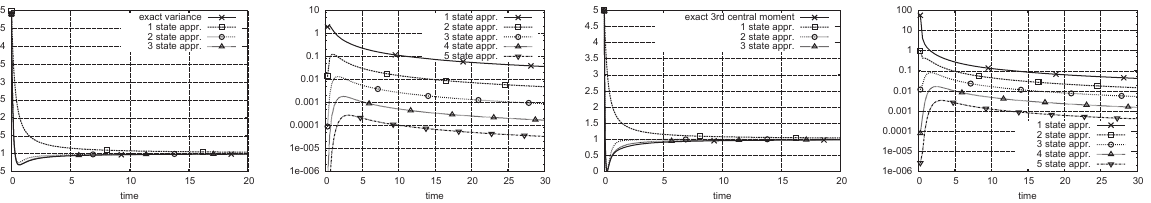
Figure 2: Variance (first plot), relative error of variance (second), third central moment (third) and relative error of the third central moment (fourth) with λ = 1 ,μ = 5 and initially empty system.